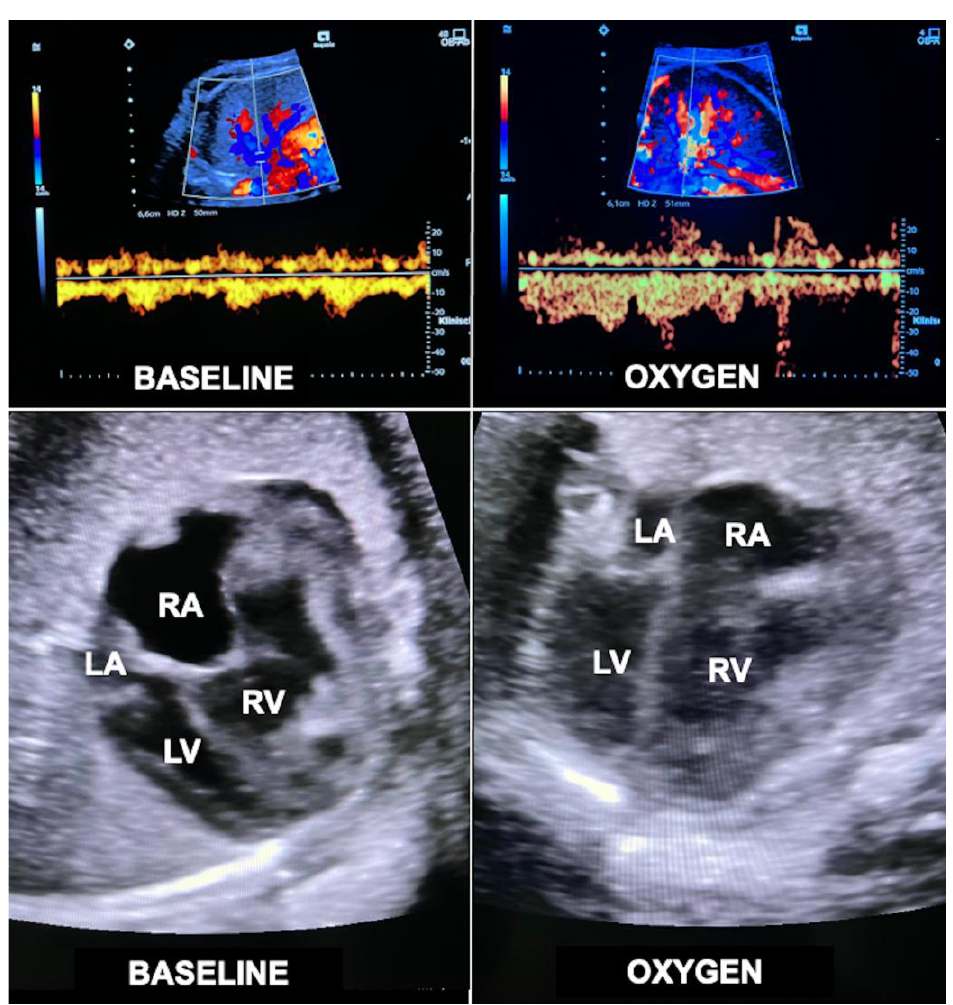
Figure 11. Acute loading effect of materno – fetal hyperoxygenation on the left ventricle in a fetus with hypoplastic left heart complex at 34 + 2 weeks of gestation. Top — color Doppler interrogation of a pulmonary vein before ( left ) and after 10 min ( right ) of materno – fetal hyperoxygenation demonstrates a marked increase in pulmonary flow. Bottom left — there is marked disproportion between the hypoplastic left (LV) and the dilated right ventricle (RV) before hyperoxygenation (BASELINE). Bottom right — after only 10 min of materno – fetal hyperoxygenation (OXYGEN), the left ventricle shows substantially improved filling at end diastole. Over several weeks, this effect results in catch-up growth of hypoplastic left heart structures. LA = left atrium; RA = right atrium.